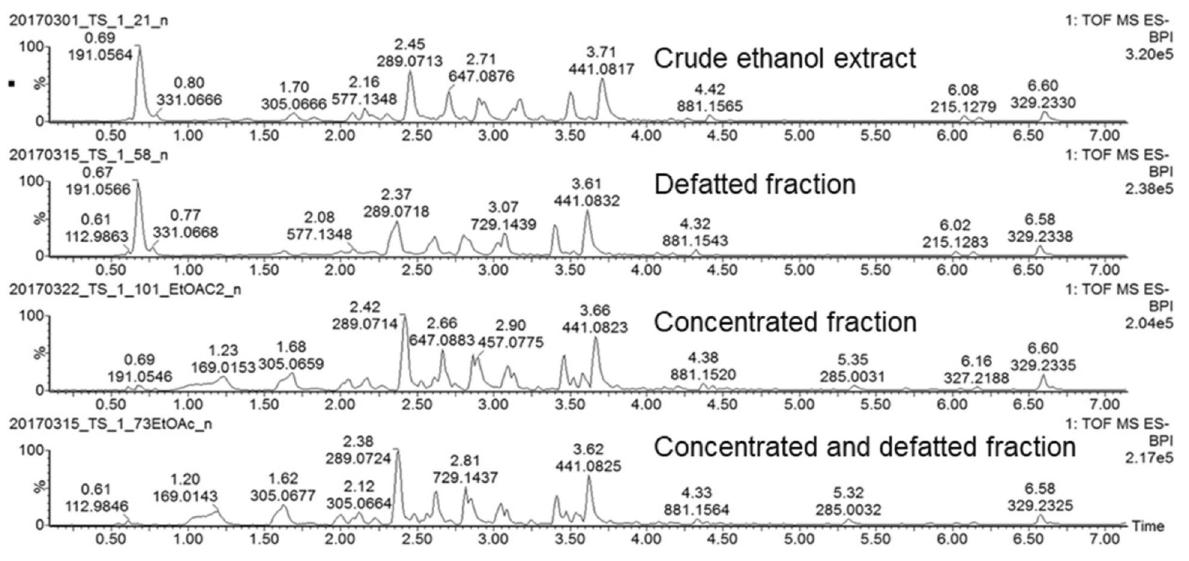
Fig. 5 Negative mode BPI chromatograms of Marula stem ethanol extract and its